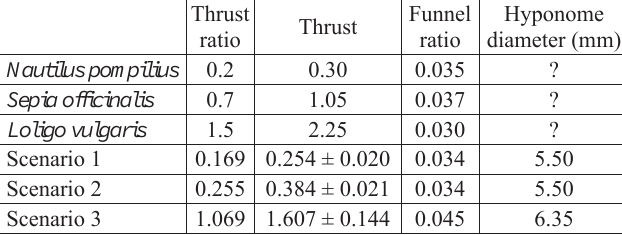
Table 1. Thrust ratio (maximum propulsive thrust/total weight), thrust generated with the weight of the Baculites compressus model (thrust ratio × 9.8 m/s 2 × 0.153 kg), funnel ratio (max cross-sectional area of funnel/volume 2/3 ), and hyponome diameter for Nautilus pompilius